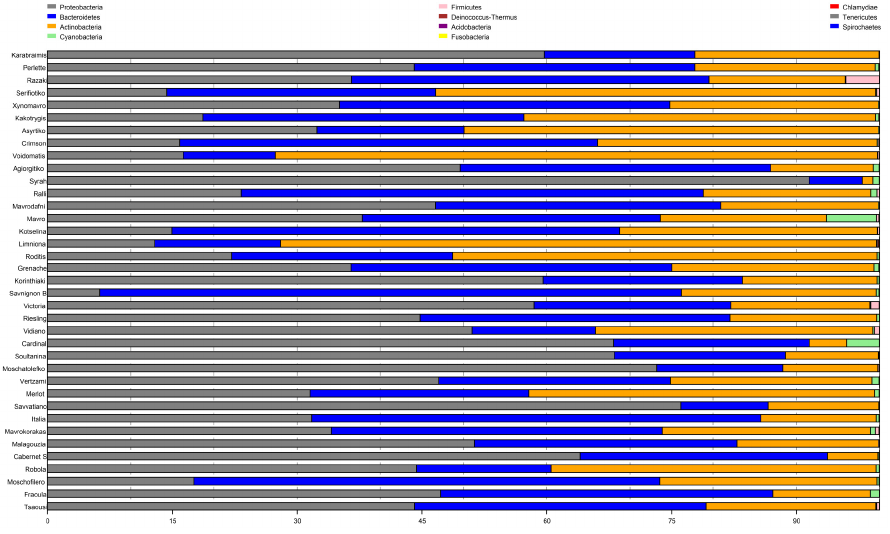
Figure 2. Relative abundance of the 11bacterial phyla of each grapevine based on the classified reads 5 Figure 2. The relative abundance of the 11 bacterial phyla of each grapevine based on the classified reads. Microbial diversity indices varied among cultivars. Richness (Chao1) scores ranged among the cultivars from 183 to 544 (Table 2). Specifically, Cabernet Sauvignon held the lowest and Korinthiaki the highest Chao1 score. Regarding OTUs, the highest value was obtained by Limniona (266 and 164), both including and excluding singletons, respectively. The lowest values were shown by Cabernet Sauvignon with singletons (88), and by Grenache (37) excluding singletons (Table 2). Shannon diversity ranged from 1.2 (for Syrah) to 3.1 (for Mavrokorakas). Simpson’s evenness index ranged from 0.45 to 0.92 for Savvatiano and Mavrokorakas,